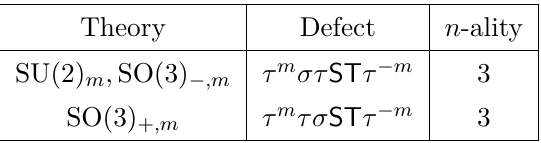
Table 2 . Non-invertible symmetries of su (2) at τ YM = e 2 πi/ 3